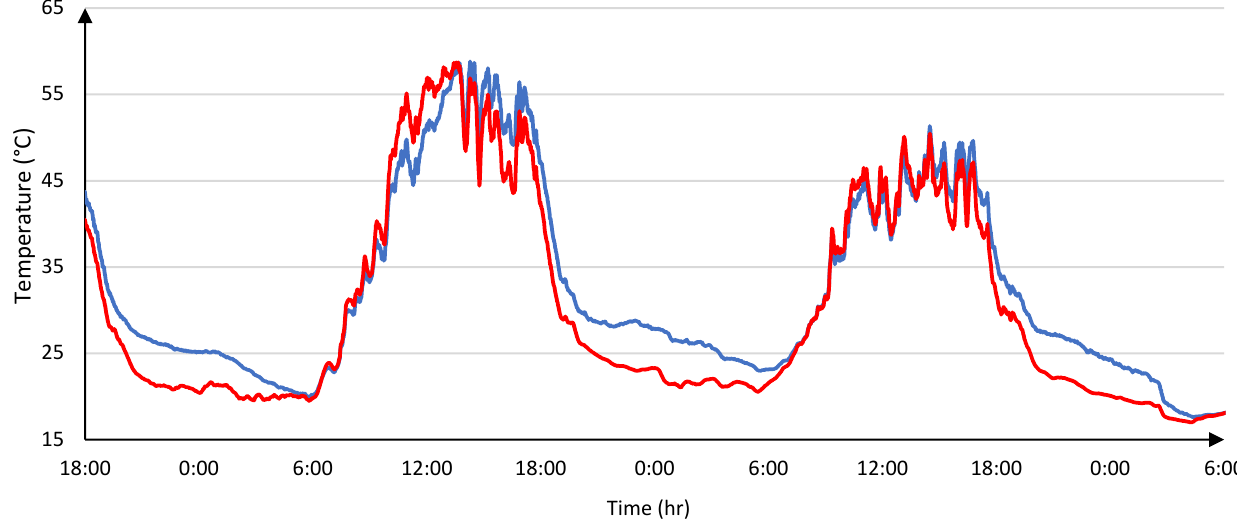
Figure 11. Front temperature of the simple PV panel (red line) and the enhanced panel (blue line).